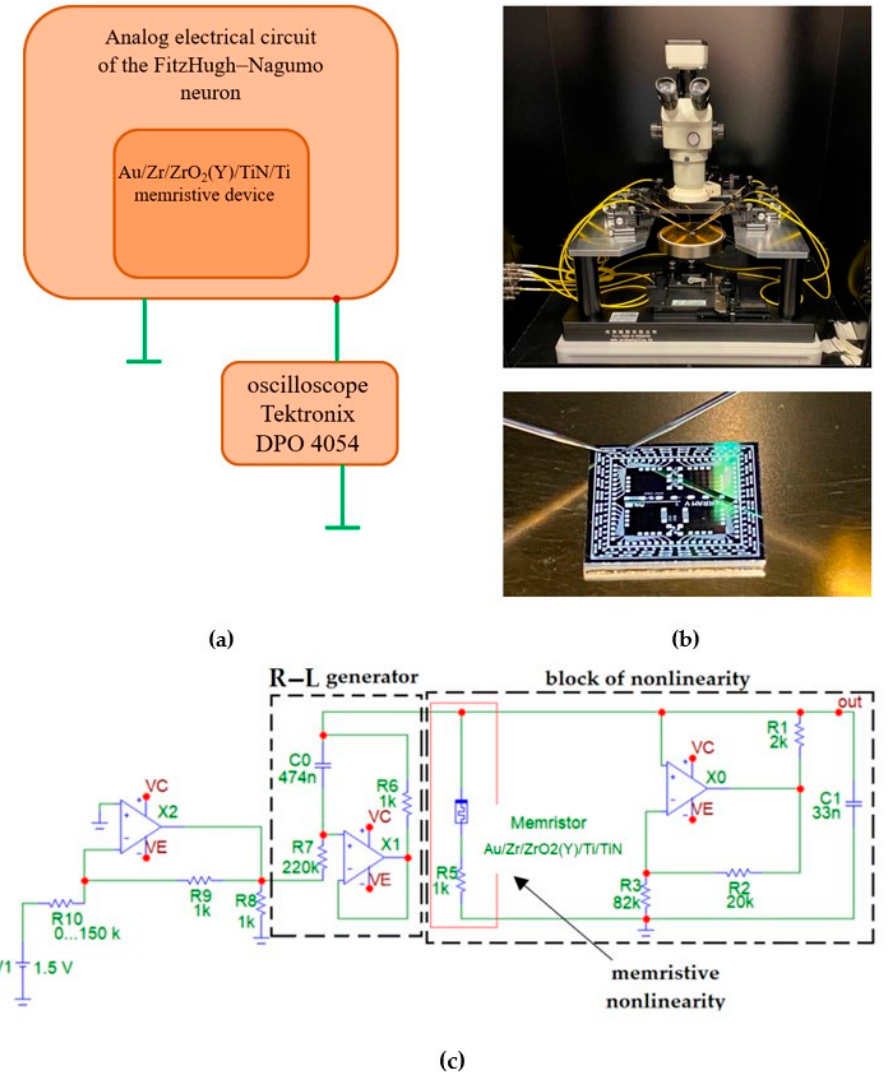
Figure 5. ( a ) Block diagram of a neuron–like memristive generator FHN; ( b ) device for determining I–V characteristics and memristive chip; ( c ) analog electric circuit of the FHN neuron containing memristive device. The nonlinearity is set using a memristive device. The capacitor C1 is responsible for the membrane of the neuron, and the power source V1 is associated with a reversible potential (an equilibrium potential).